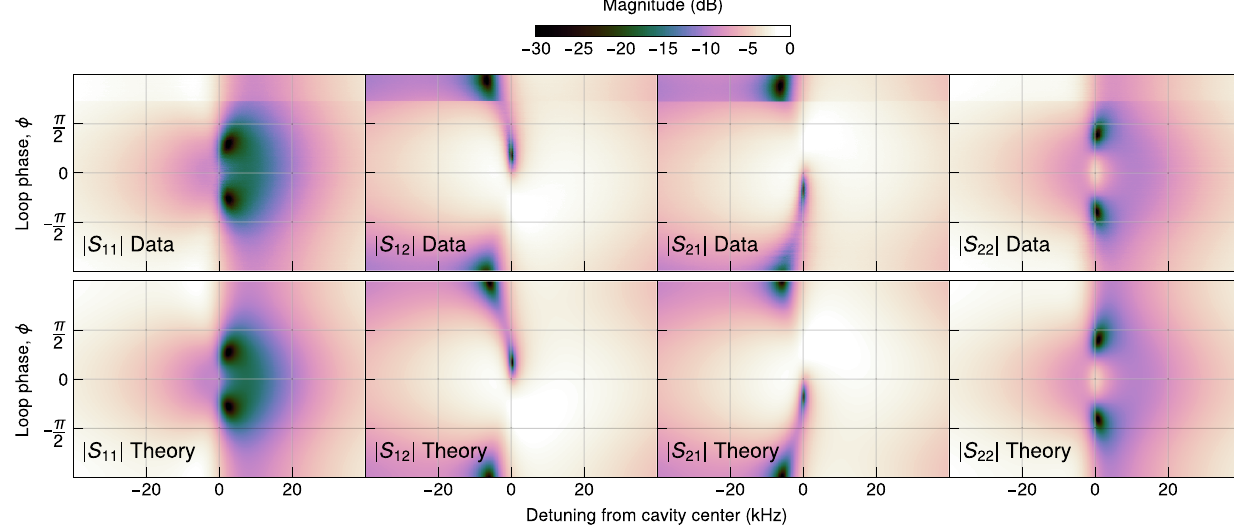
6. Full scattering matrix including transmission and reflection. Measured scattering parameters are shown on the top row and the results of a least-squares fit to our expanded coupled-mode theory are shown on the bottom